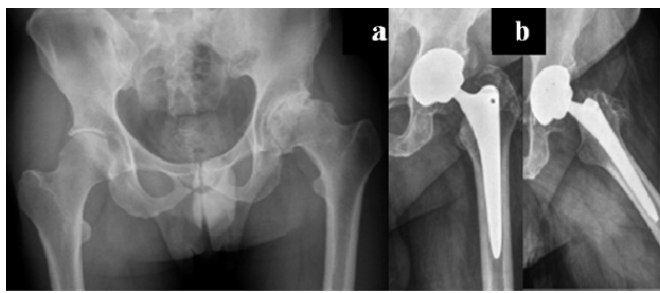
Figure 3. ( a) Preoperative X ‐ rays of the left hip of a 58 ‐ year ‐ old patient affected by severe haemophilia A; ( b ) Radiographic aspect 6.5 years after surgery: Standard cementless tapered stem with ceramic ‐ on ‐ polyethylene (COP) coupling.